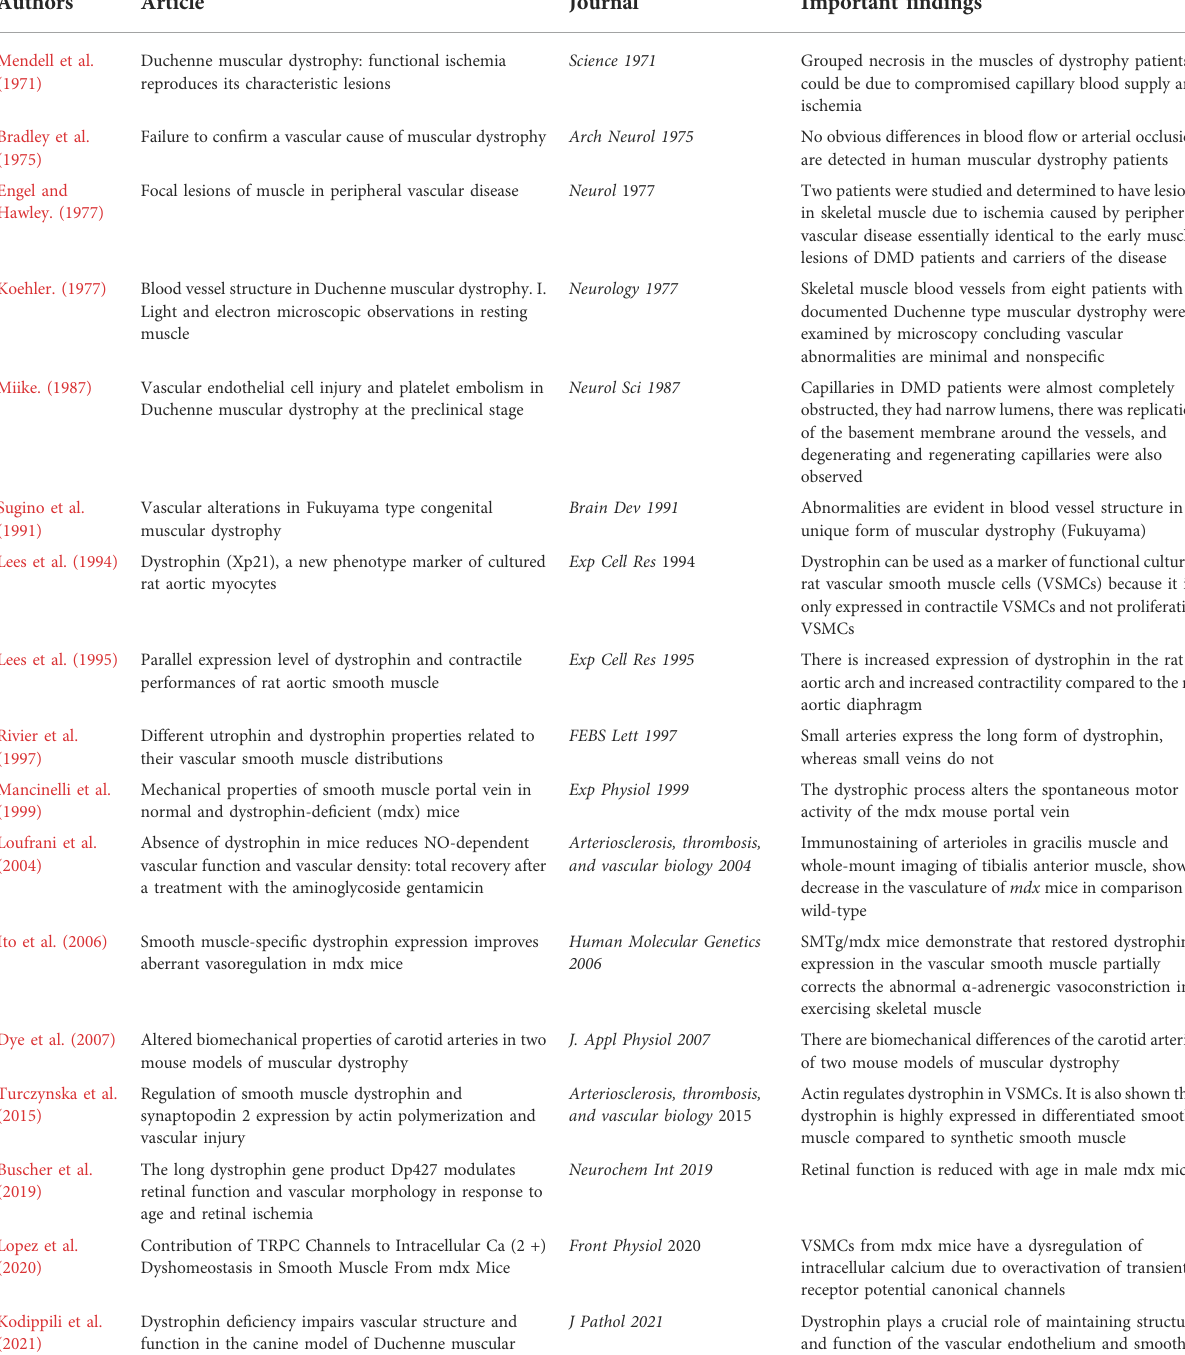
TABLE 1 Key papers highlighting connection between dystrophin and vascular smooth